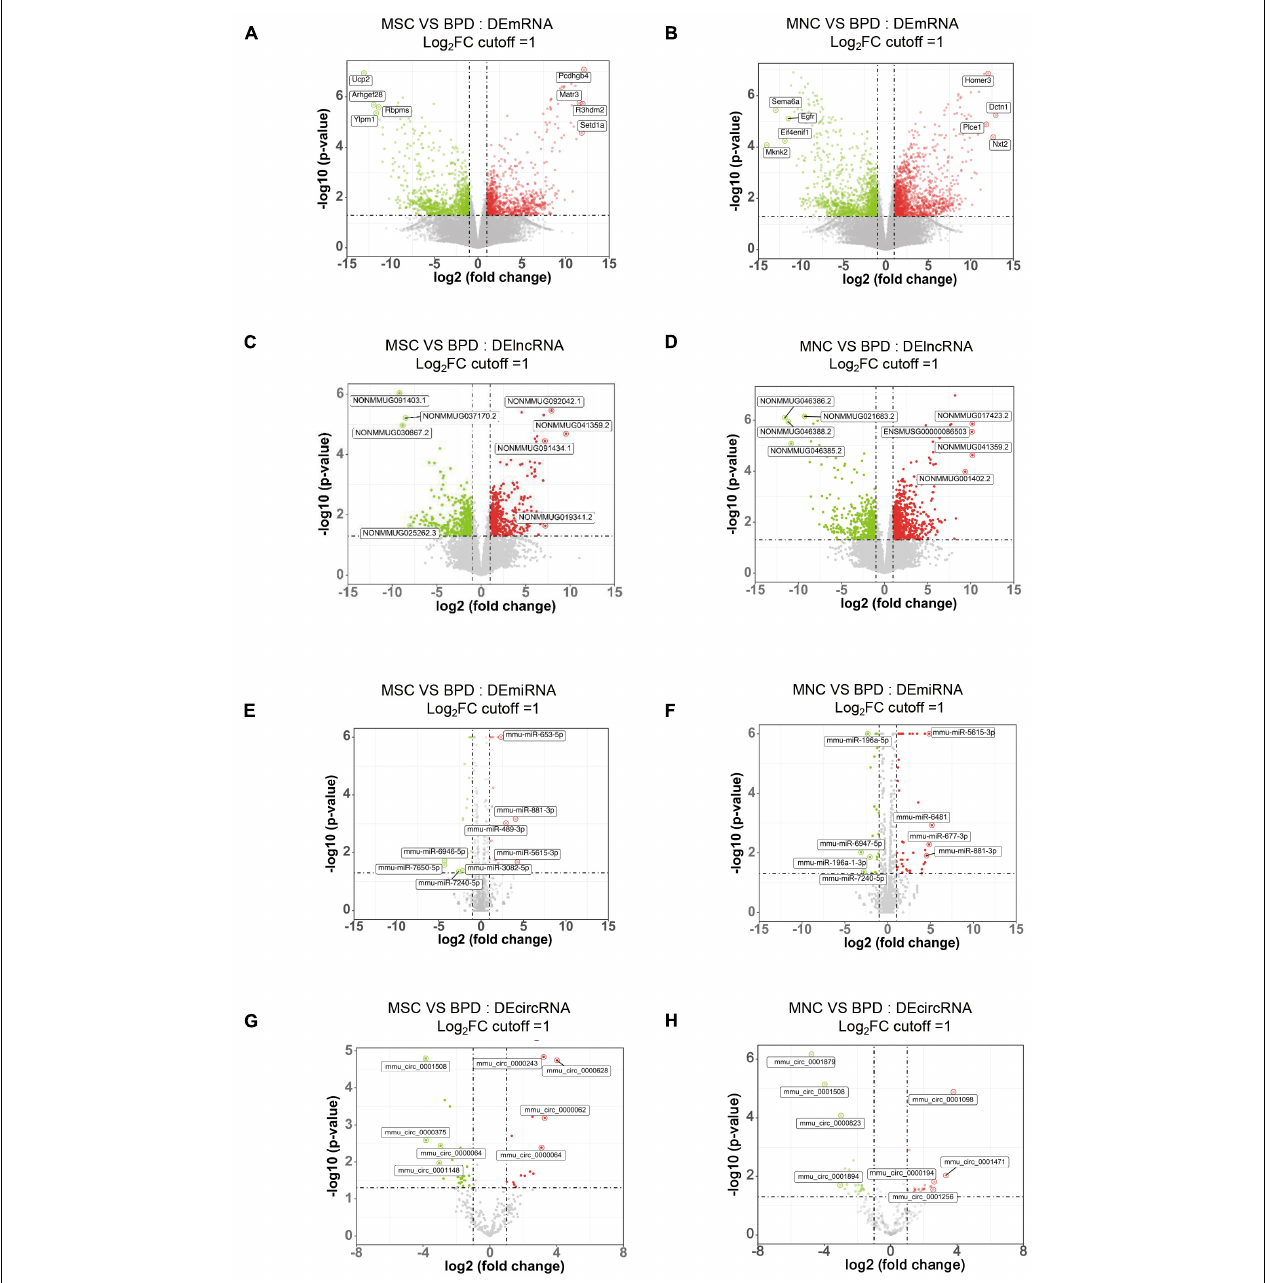
FIGURE 7 | Expression profiles of distinct RNAs. (A,B) Expression profiles of mRNAs. In the volcano plots, red, green, and black points represent mRNAs that were downregulated, upregulated, and not significantly different in UC-MSC-infused mice (A) and CB-MNC-infused mice (B) relative to bronchopulmonary dysplasia (BPD) mice, respectively. x axis: log2 ratio of mRNA expression levels between stem cell-infused BPD mice and BPD mice. y axis: false discovery rate values ( − log10 transformed) of mRNAs. (C,D) Expression profiles of lncRNAs. In the volcano plots, red, green, and black points represent circRNAs that were downregulated, upregulated, and not significantly different in umbilical cord-derived mesenchymal stem cells (UC-MSC)-infused mice (E) and cord blood-derived mononuclear cell (CB-MNC)-transplanted mice (F) relative to BPD mice. x axis: log2 ratio of lncRNA expression levels between stem cell-infused BPD mice and BPD mice. y axis: false discovery rate values (-log10 transformed) of circRNAs. (E,F) Expression profiles of circRNAs. In the volcano plots, red, green, and black points represent circRNAs that were downregulated, upregulated, and not significantly different in UB-MSC-infused mice (E) and CB-MNC-infused mice (F) relative to BPD mice. x axis: log2 ratio of circRNA expression levels between stem cell-infused BPD mice and BPD mice. y axis: false discovery rate values ( − log10 transformed) of circRNAs. (G,H) Expression profiles of miRNAs. In the volcano plots, red, green, and black points represent miRNAs that were downregulated, upregulated, and not significantly different in UB-MSC-infused mice (G) and CB-MNC-infused mice (H) relative to BPD mice. x-axis: log2 ratio of miRNA expression levels between stem cell-infused BPD mice and BPD mice. y axis: false discovery rate values (-log10 transformed) of miRNAs.